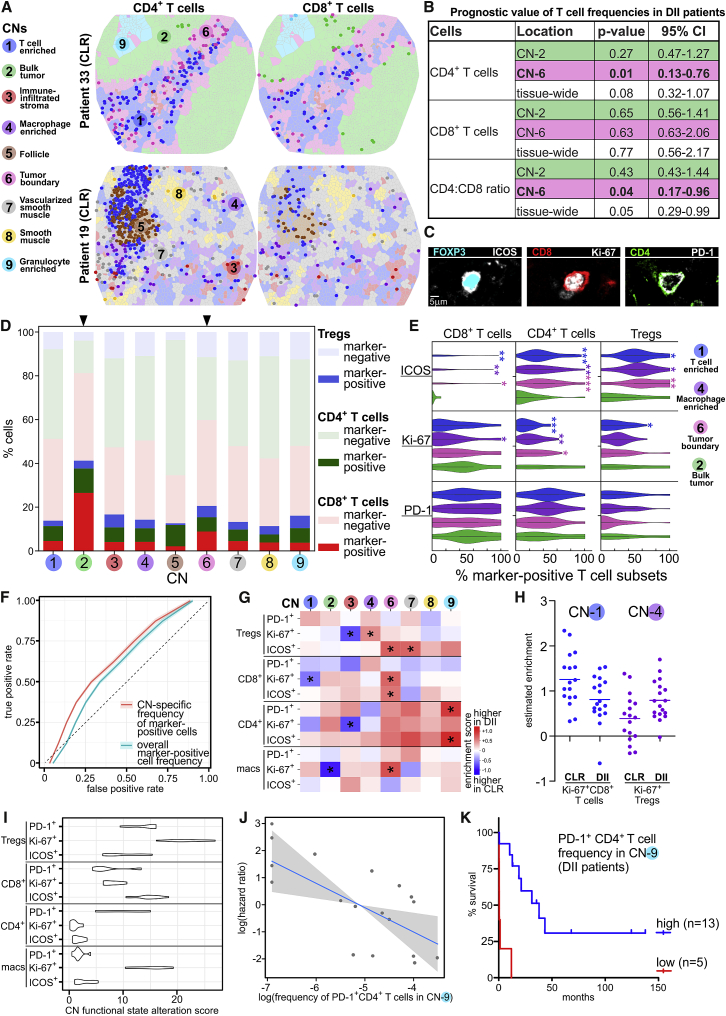
CN Functional States Are Indicators of Antitumoral Immunity(A) Example Voronoi diagrams of TMA spots, colored by CN, with CD4+ (left) and CD8+ T cells (right) overlaid in each CN as points of the corresponding CN color.(B) Table of Cox proportional hazards regression results for T cell frequencies in the indicated CNs. Each CN-specific frequency was tested individually in a distinct model (DII patients: n = 18, 13 deaths).(C) Example staining for ICOS, Ki-67, and PD-1 on different T cell subsets.(D) Relative proportions of CD4+ (FOXP3−) T cells, CD8+ T cells, and Treg cells positive for at least one of the functional markers (ICOS, Ki-67, and PD-1) in each CN. Pooled data from all patients are shown (cell numbers: CN-1, 17,822; CN-2, 735; CN-3, 4,031; CN-4, 11,753; CN-5, 4,695; CN-6, 2,681; CN-7, 4,504; CN-8, 1,368; CN-9, 2,884).(E) Violin plots of CN-specific CT frequencies of marker-positive CD4+ T cells, CD8+ T cells, and Treg cells in CN-1, CN-2, CN-4, and CN-6. Asterisks indicate significant differences in the CN-specific CT frequency below compared with the frequency in CN-2 (bulk tumor), tested across patients (∗p < 0.05, ∗∗p < 0.01, ∗∗∗p < 0.001, Student’s t test).(F) Receiver operating characteristic curves comparing the performance of L1-regularized logistic regression classifiers (CN-specific CT frequency versus overall frequency of marker-positive cells) over repeated holdout samples to classify patients by group.(G) Heatmap of estimated differential enrichment coefficients (∗p < 0.05, not adjusted for multiple tests). A positive coefficient (red) indicates that the corresponding CT is more enriched in DII patients in the given CN.(H) Estimated enrichment of Ki-67+ CD8+ T cells in CN-1 and Ki-67+ Treg cells in CN-4 for each patient. Horizontal lines represent the means across patients.(I) Estimated CN functional state alteration score for each CT. Variation corresponds to the distribution of the score across 10 resampling iterations.(J) Partial residual plot of the log frequency of PD-1+CD4+ T cells in CN-9 versus the estimated log hazard ratio with respect to overall survival in DII patients (p = 0.006; n = 18, 13 deaths; Cox proportional hazards regression). A pseudocount of 0.001 was added to the frequency for all patients when logarithms were computed.(K) Kaplan-Meier curves for overall survival in DII patients corresponding to the best splitting of DII patients into two groups along the CN-9-specific frequency of PD-1+CD4+ T cells.See also Figure S5, Figure S6A, and S6B, and STAR Methods.